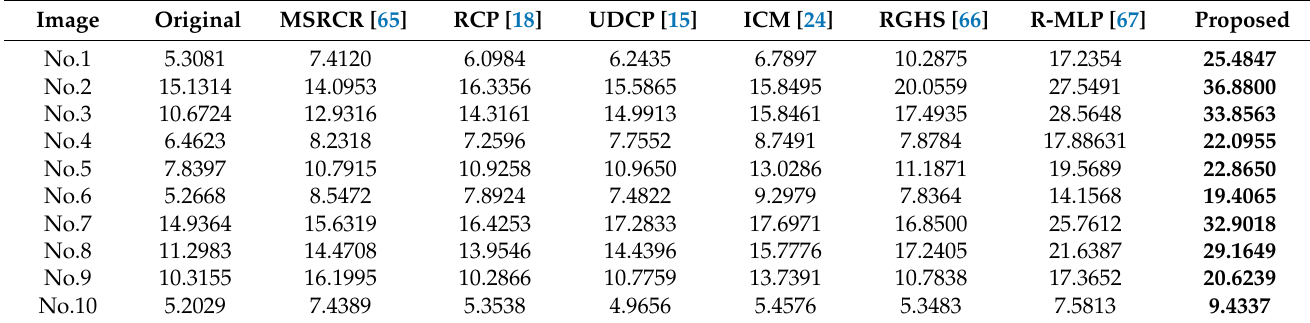
Table 2. Evaluation of images by RMS contrast.